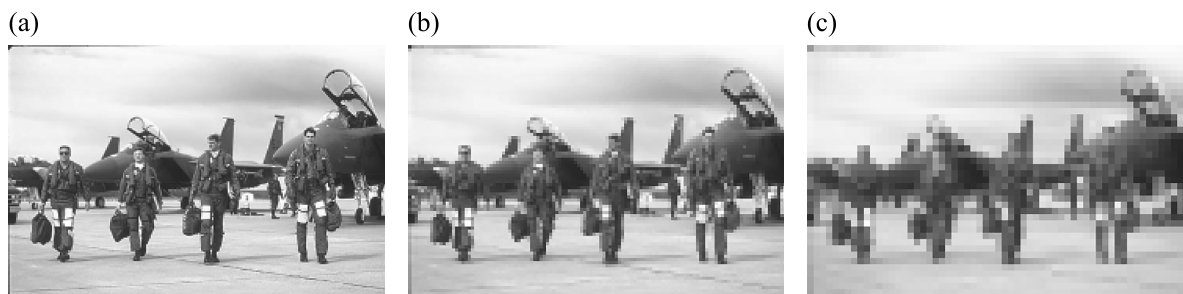
Fig. 7. The example of an image with MD where the Haar wavelet transformation is applied to three levels of decomposition.